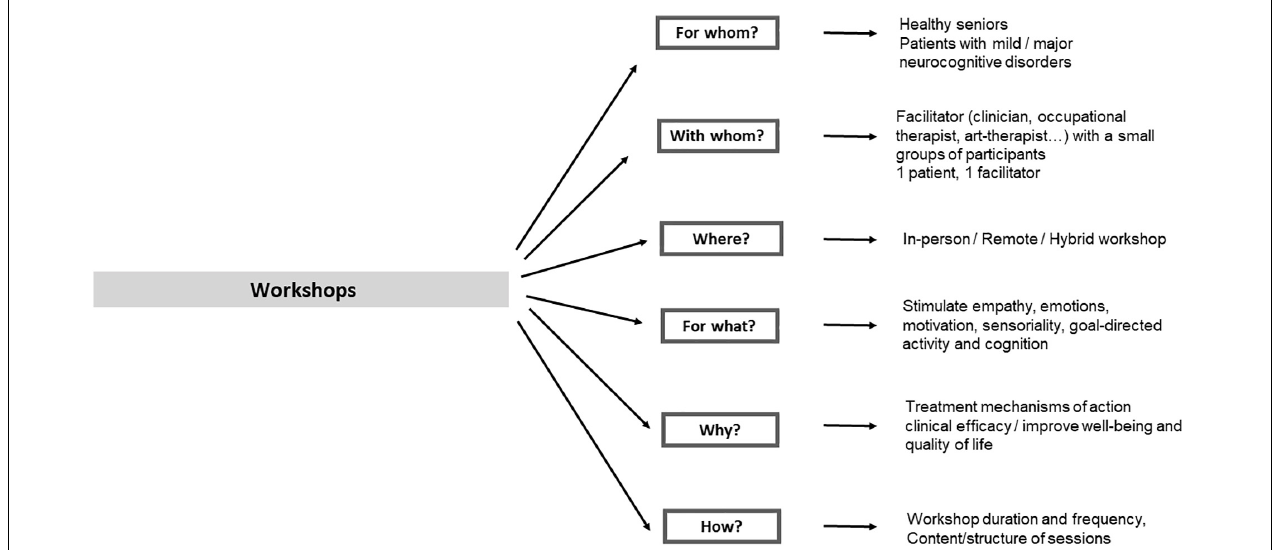
FIGURE 1 | Main parameters defining the features of a workshop